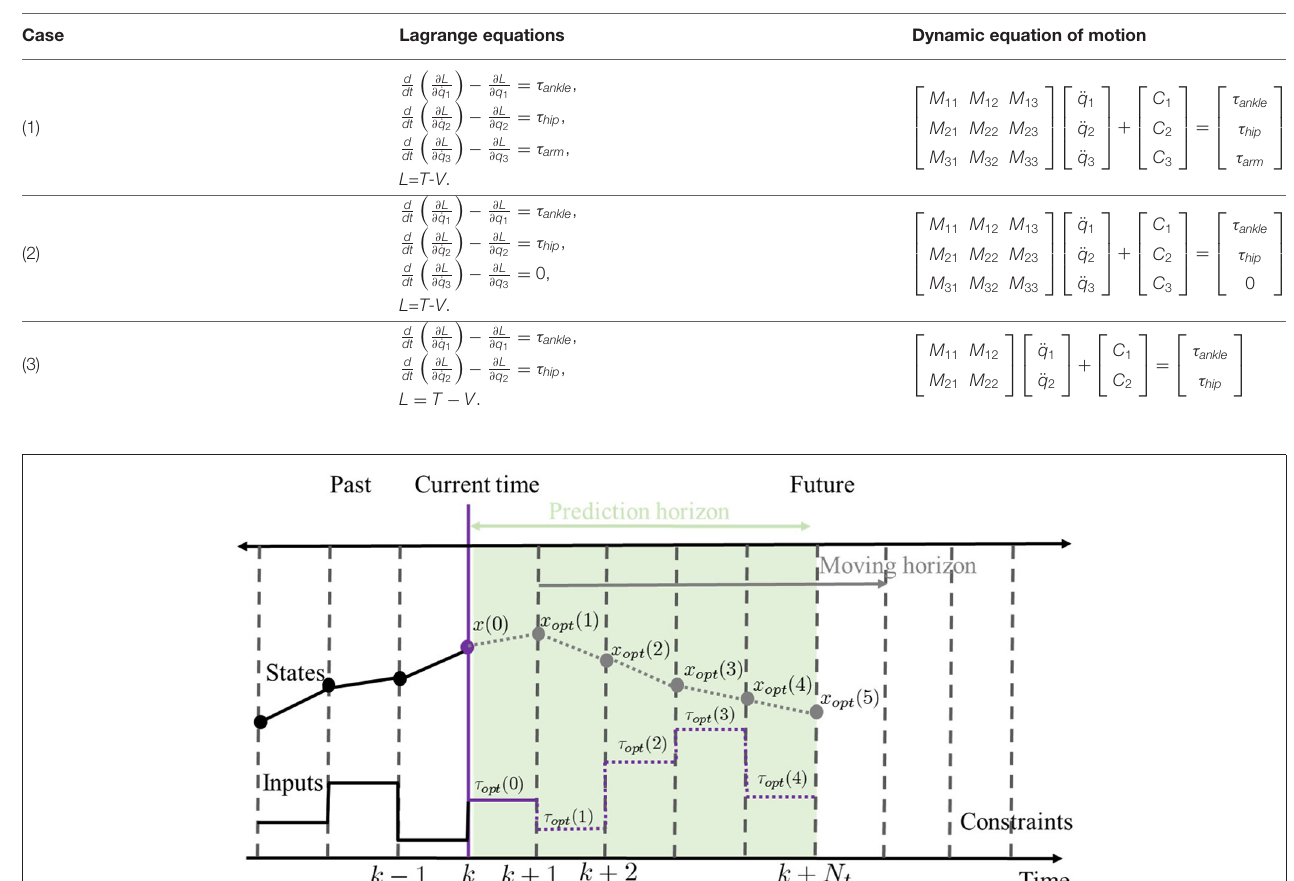
TABLE 2 | Lagrange equations and dynamic equation of motions for the model with three different cases: (1) active arms; (2) passive arms; (3) fixed arms. Case Lagrange equations Dynamic equation of motion